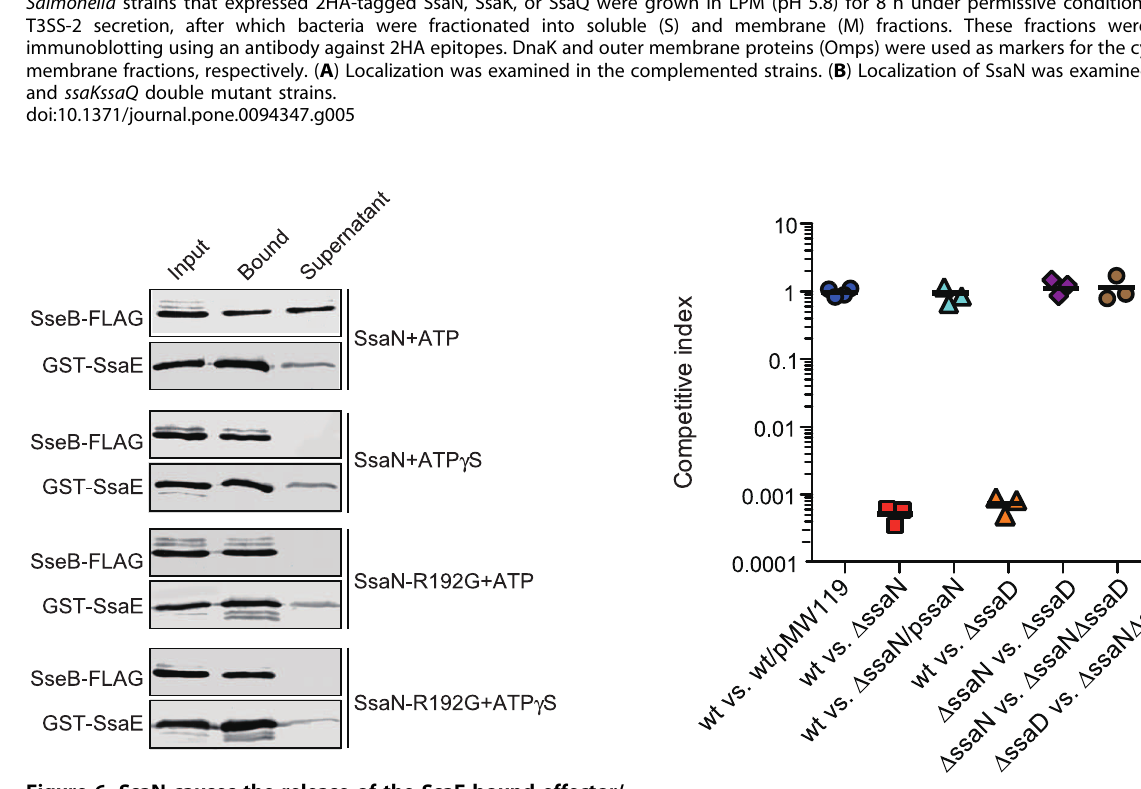
Figure 7. SsaN is required for T3SS-2 dependent mouse virulence in vivo . Mice were infected peritoneally with an equal mixture of the two indicated bacterial strains. The CI values for the spleen were determined at 48 h after infection. Horizontal bars indicate the mean CI values and individual CI values are shown.